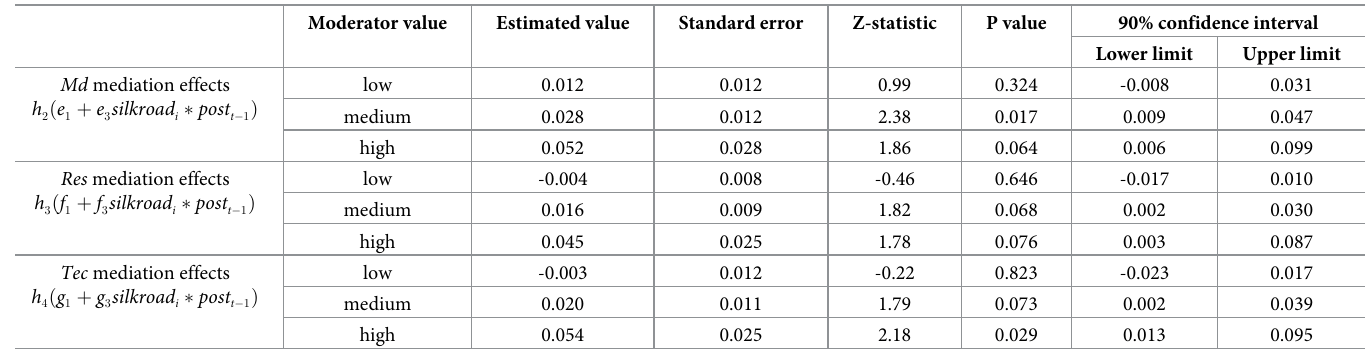
Table 8. Significance test of moderated mediation effects at different moderator